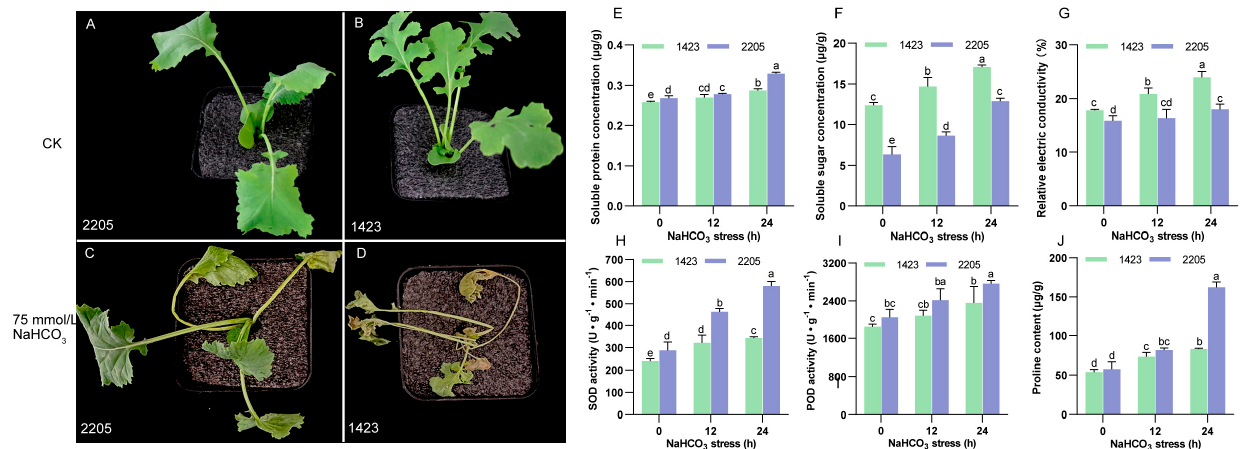
Figure 1. Phenotypical photographs and physiological responses of lines 2205 and 1423 under con- trol and alkaline salt stress. Line 2205 ( A ) and line 1423 ( B ) seedlings in the Hoagland nutrient solu- tion, 7 − day − stress 2205 ( C ) and 1423 ( D ) seedlings using 75 mmol/L NaHCO 3 . Bar graph represents the content of soluble protein ( E ), soluble sugar ( F ), relative electric conductivity ( G ), the activity of superoxide dismutase ( H ), and peroxidase ( I ), and proline content ( J ). The assays were repeated three times with three biological replicates. Different letters indicate significant differences detected by the least significant difference test ( p < 0.05).